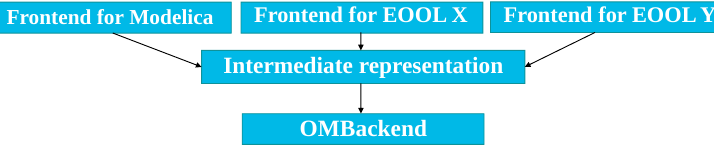
Figure 3. A high-level overview of a design separating the intermediate representation from the frontend to allow several hypothetical frontends to use the same